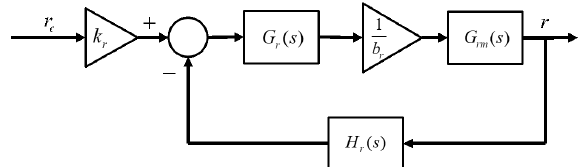
Figure 8. The structure of yaw angular rate loop control.